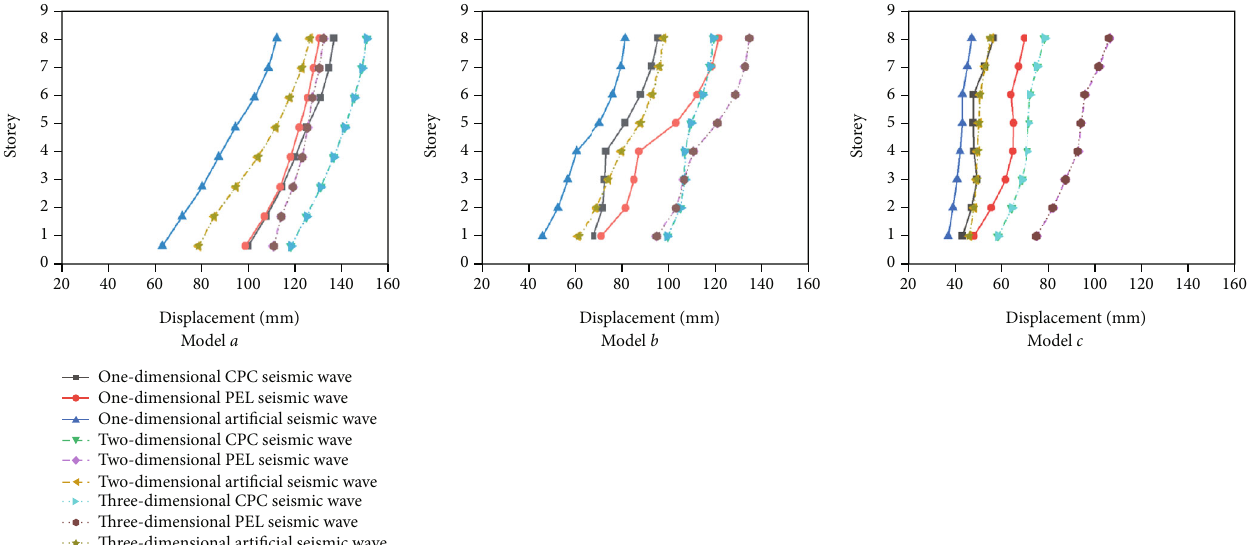
Figure 10: Comparison of fl oor displacements of di ff erent models in X -direction.